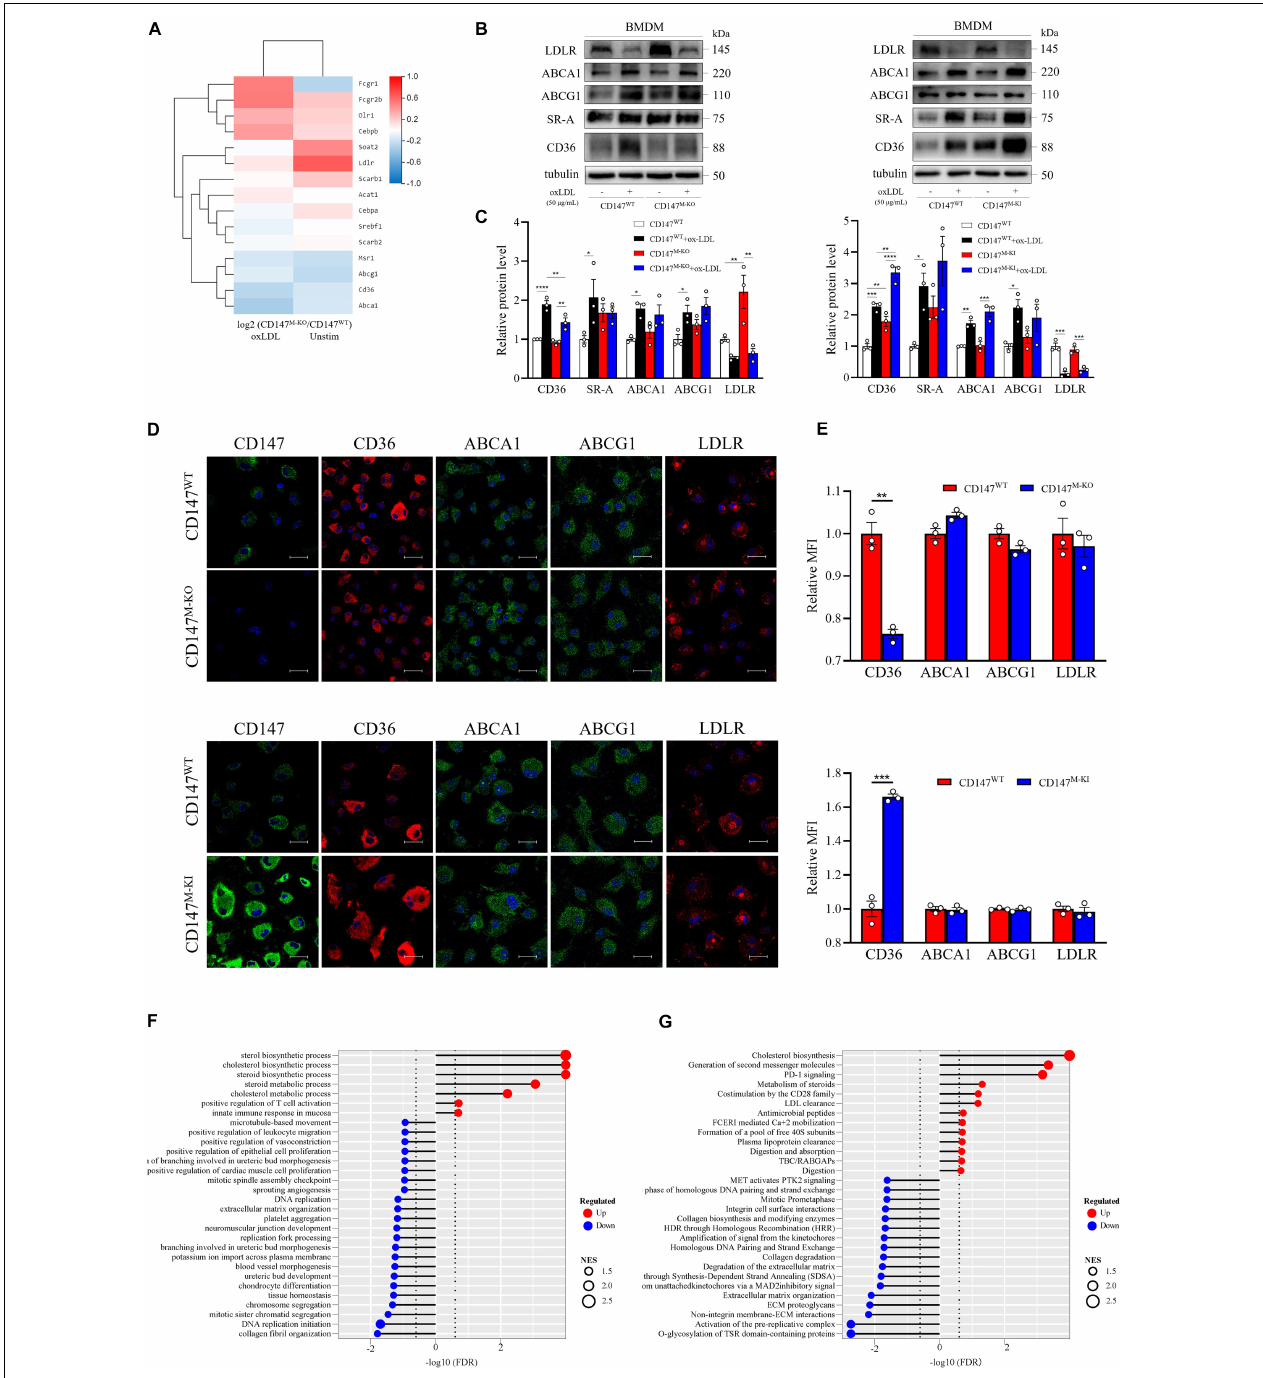
FIGURE 7 | Macrophage-specific CD147 deficiency diminishes CD36 expression and may exert other protective effects in atherosclerosis. (A) BMDMs from CD147 WT and CD147 M − KO treated with or without ox-LDL (50 µ g/mL) for 24 h were analyzed by RNA sequencing. The selected genes involved in foam cell formation were graphed in a heatmap. (B) Western blot analysis of LDLR, ABCA1, ABCG1, SR-A, and CD36 in BMDMs isolated from CD147 M − KO and CD147 M − KI mice and their respective CD147 WT littermates incubated with or without ox-LDL (50 µ g/mL) for 24 h. (C) Quantification of protein levels of molecules in (B) relative to tubulin. (D) Immunofluorescence staining of CD147, CD36, ABCA1, ABCG1, and LDLR in BMDMs isolated from CD147 M − KO and CD147 M − KI mice and their respective CD147 WT littermates treated with ox-LDL (50 µ g/mL) for 24 h. Scale bar, 20 µ m. (E) Quantification of the MFI of (D) by means of the Image-Pro Plus 6.0 software. (F,G) GESA GO enrichment analysis for biological process (F) and GESA reactome enrichment analysis (G) are shown as lollipop charts. Statistical significance in gene sets was defined as an FDR < 0.25; NES represents enrichment magnitude and is shown as the size of the point. The − log 10 (FDR) of the enrichment is shown on the x -axis; the enriched gene set is shown on the y -axis; and the color of points represent the fraction of gene sets that are significantly upregulated or downregulated. Data represent the mean ± SEM. of n = 3 biologically independent experiments. * P < 0.05, ** P < 0.01, *** P < 0.001, **** P < 0.0001.